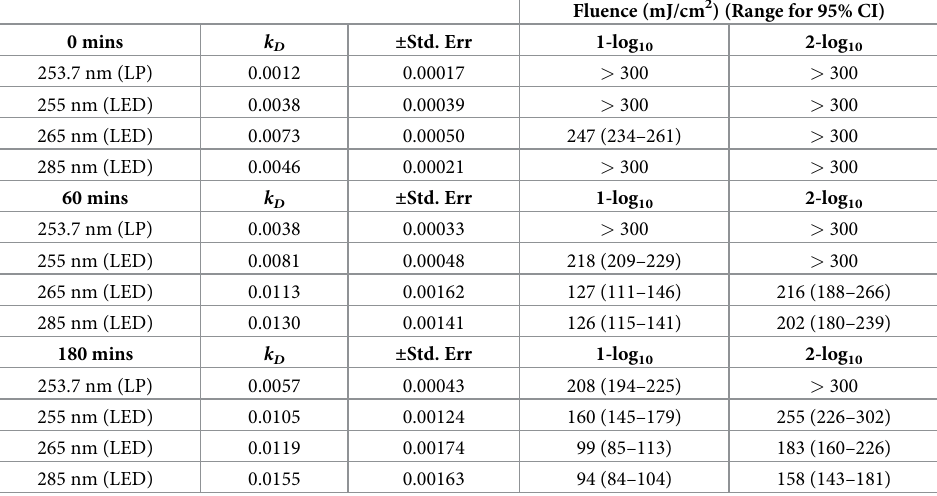
Table 2. Inactivation rate constants ( k D ) of S . mansoni cercariae for each wavelength at 0, 60, and 180 minutes post-exposure and the fluence required to achieve 1- and 2- log 10